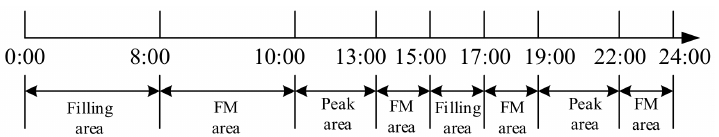
Figure 2. Division of collaborative working areas at different time